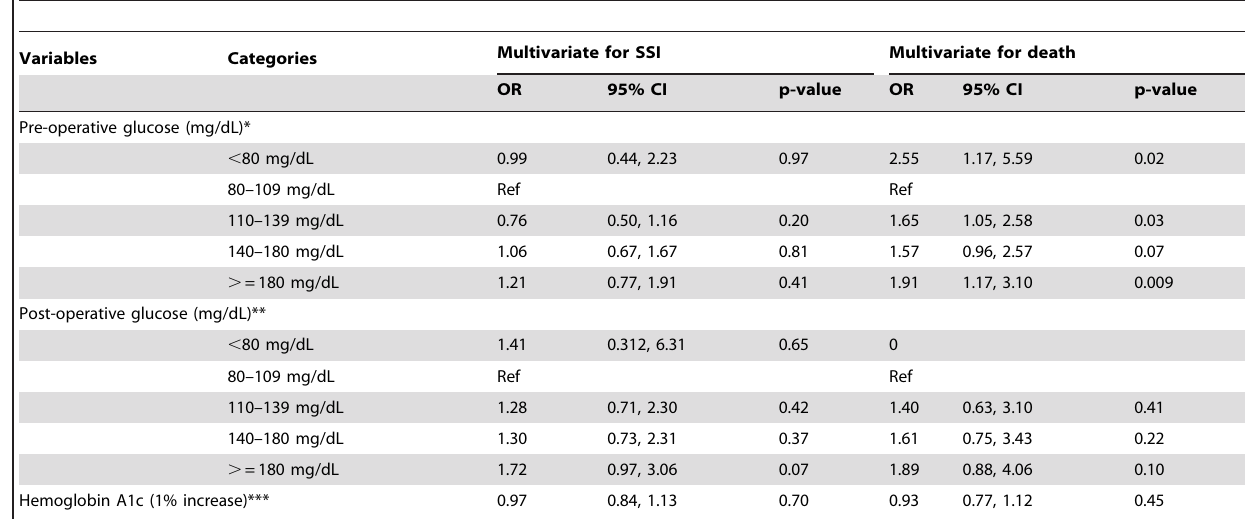
Table 3. Multivariate association between demographic, clinical and operative factors and surgical site infections and